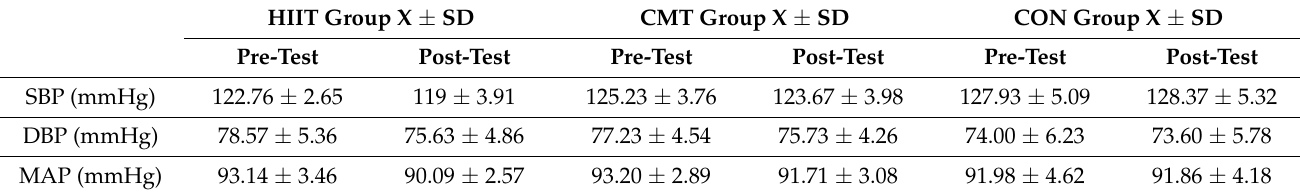
Table 2. All groups’ SBP, DBP and MAP mean (X) with standard deviation